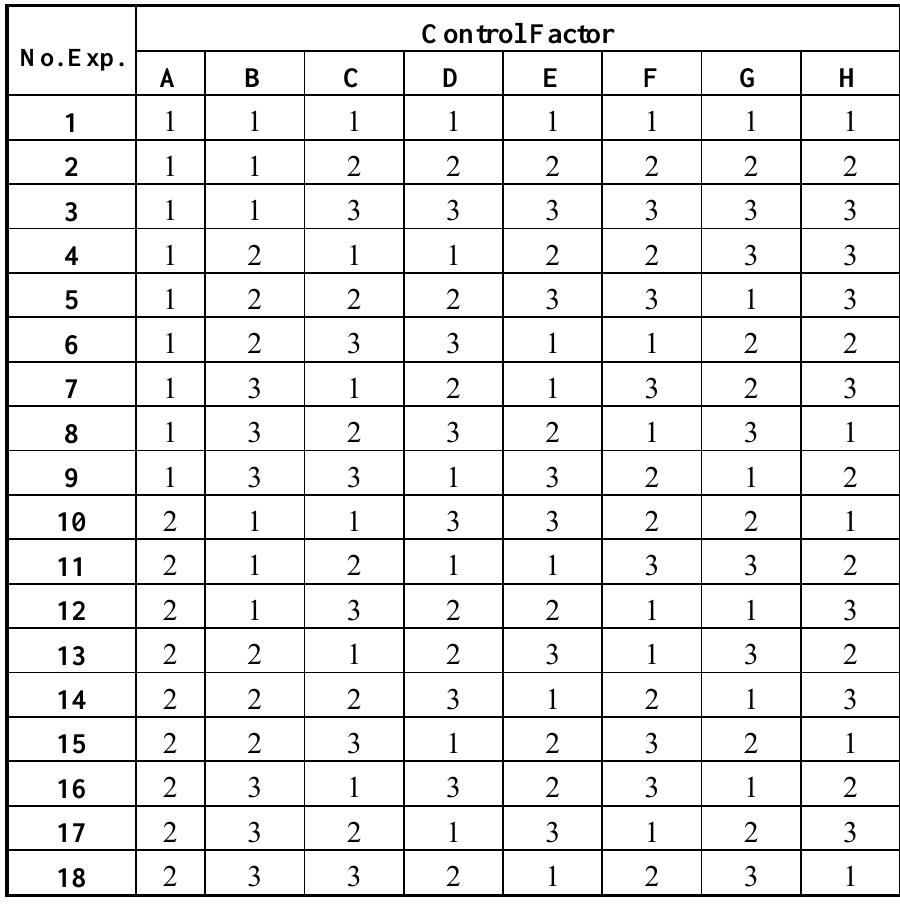
(2 1 ×3 7 ) Orthogonal Table 2. L 18